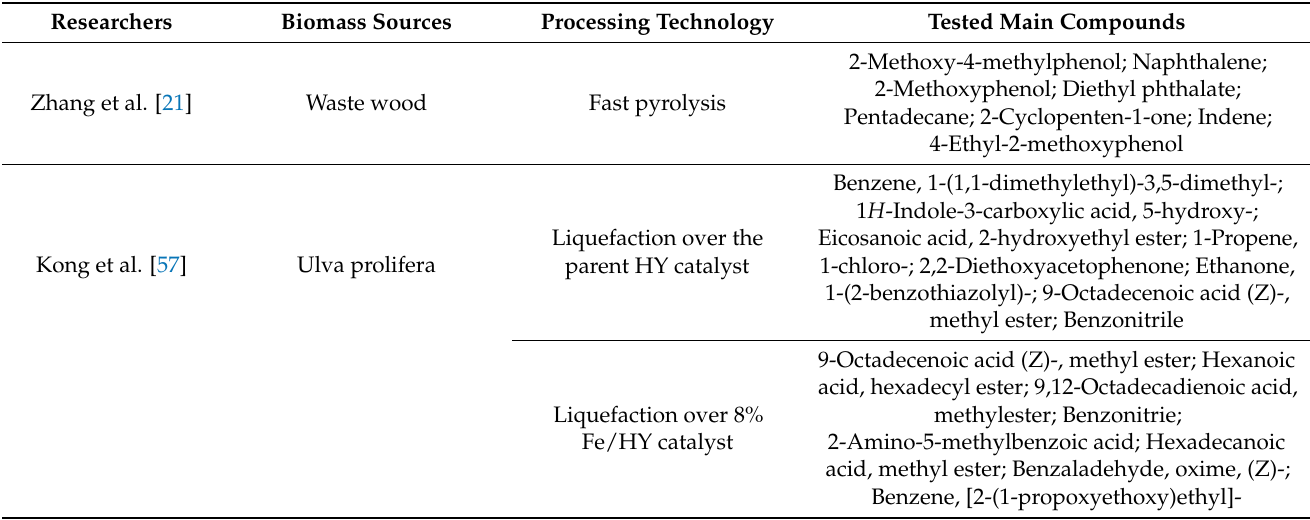
Table 4. Chemical compounds in